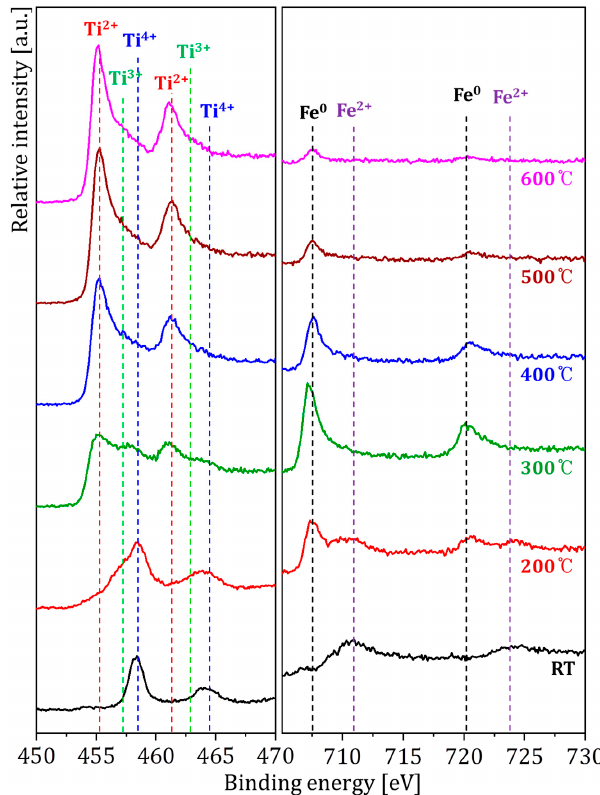
Figure 4. In situ heating X-ray photoelectron spectroscopy (XPS) of the TiFe surface observed from room temperature (RT) to 600 °C. A closer look at in situ results of the Ni- and Mn-substituted alloys (Figures 5 and 6, respectively) revealed that substitution did not alter the reduction pathway of the TiFe single phase. Indeed, not only were the same Ti and Fe ionic states indexed, but they were also found to be reduced through steps and at temperatures consistent with those described for the unmodified TiFe (Figure 4). There was thus no major difference with the reference specimen, except for the presence of Ni and Mn peaks, which are charac- terized by weaker intensities compared to those observed for the base Ti and Fe atoms due to the relatively small substitution amount utilized in this study. In addition, at room temperature, Mn was found to exist in the Mn 3+ state (at 640.8 eV [44]), which partially reduced to Mn 2+ (~639.4 eV [44]) upon a temperature increase to 300 °C. From 400 °C, the Mn 3+ state completely disappeared in favor of Mn 2+ . For TiFe 0.9 Ni 0.1 , on the other hand, only metallic Ni (Ni 0 , at 852.1 eV [45]) was present throughout heating considering that Ni had the smallest oxidation driving force among the four constituting elements (as shown earlier in Figure 3). Overall, both the thermodynamic calculations and in situ heating experiments indicate that Fe and Ni eventually coexist in the metallic state, while Ti and Mn remain ionized even after heating.